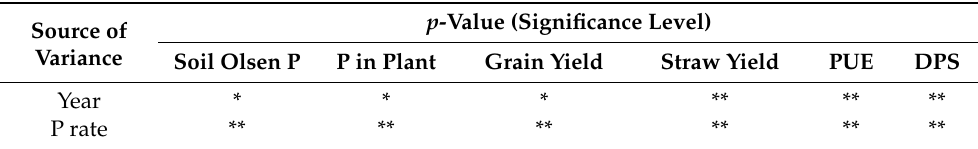
Table 4. Results of the statistical analysis of the obtained